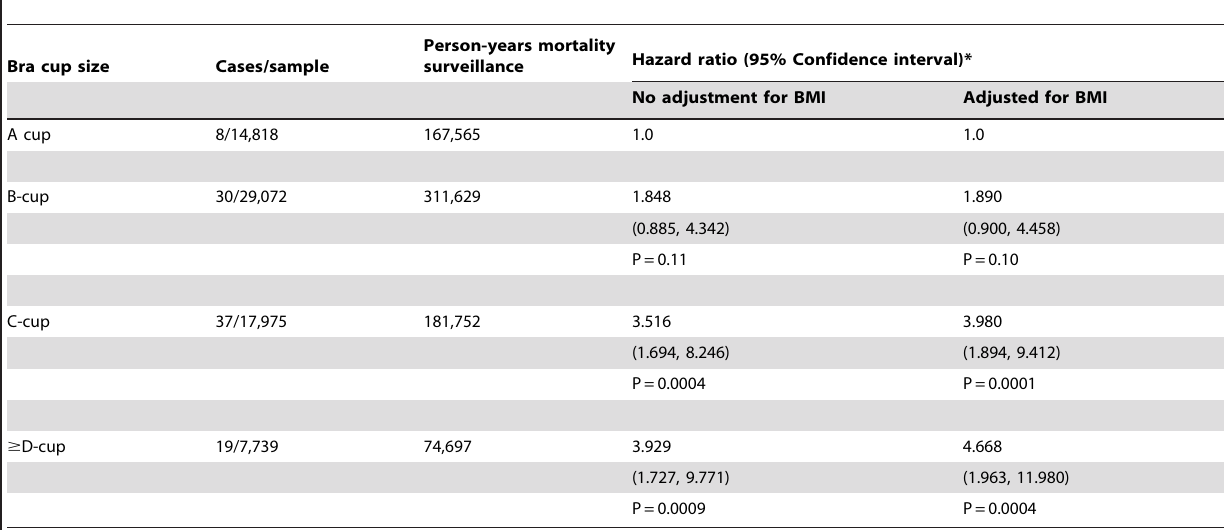
Table 4. Survival analyses for breast cancer mortality by breast volume (bra cup